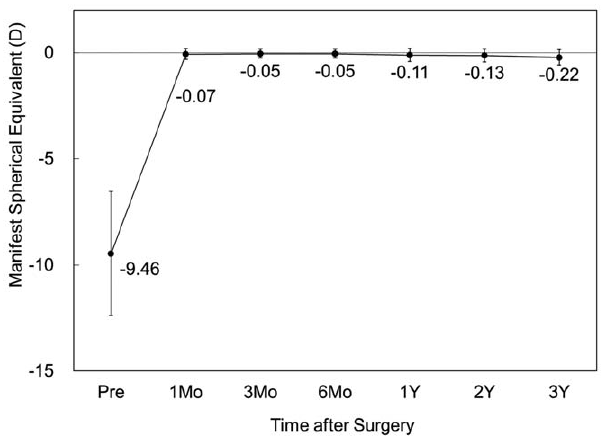
Figure 6. Time course of intraocular pressure after toric implantable collamer lens implantation. M=month,